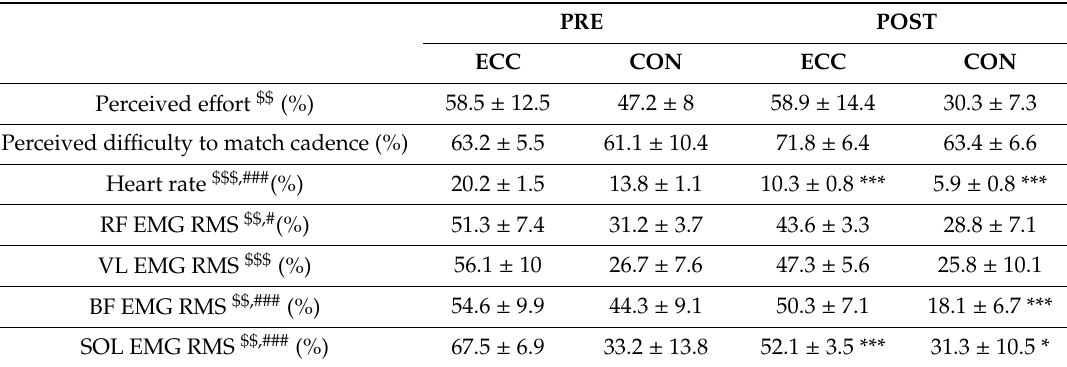
Table 2. Inter-individual coe ffi cients of variation of all